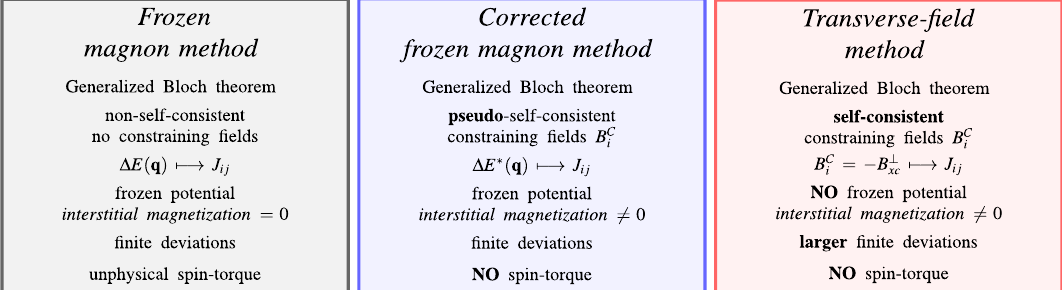
Figure 1. Three different methods for obtaining exchange parameters: the frozen magnon, the corrected frozen magnon and the transverse-field method. Due to the fact that the constraining fields in the corrected frozen magnon method are converged self-consistently, while the potential is kept fixed, we call these fields pseudo -self-